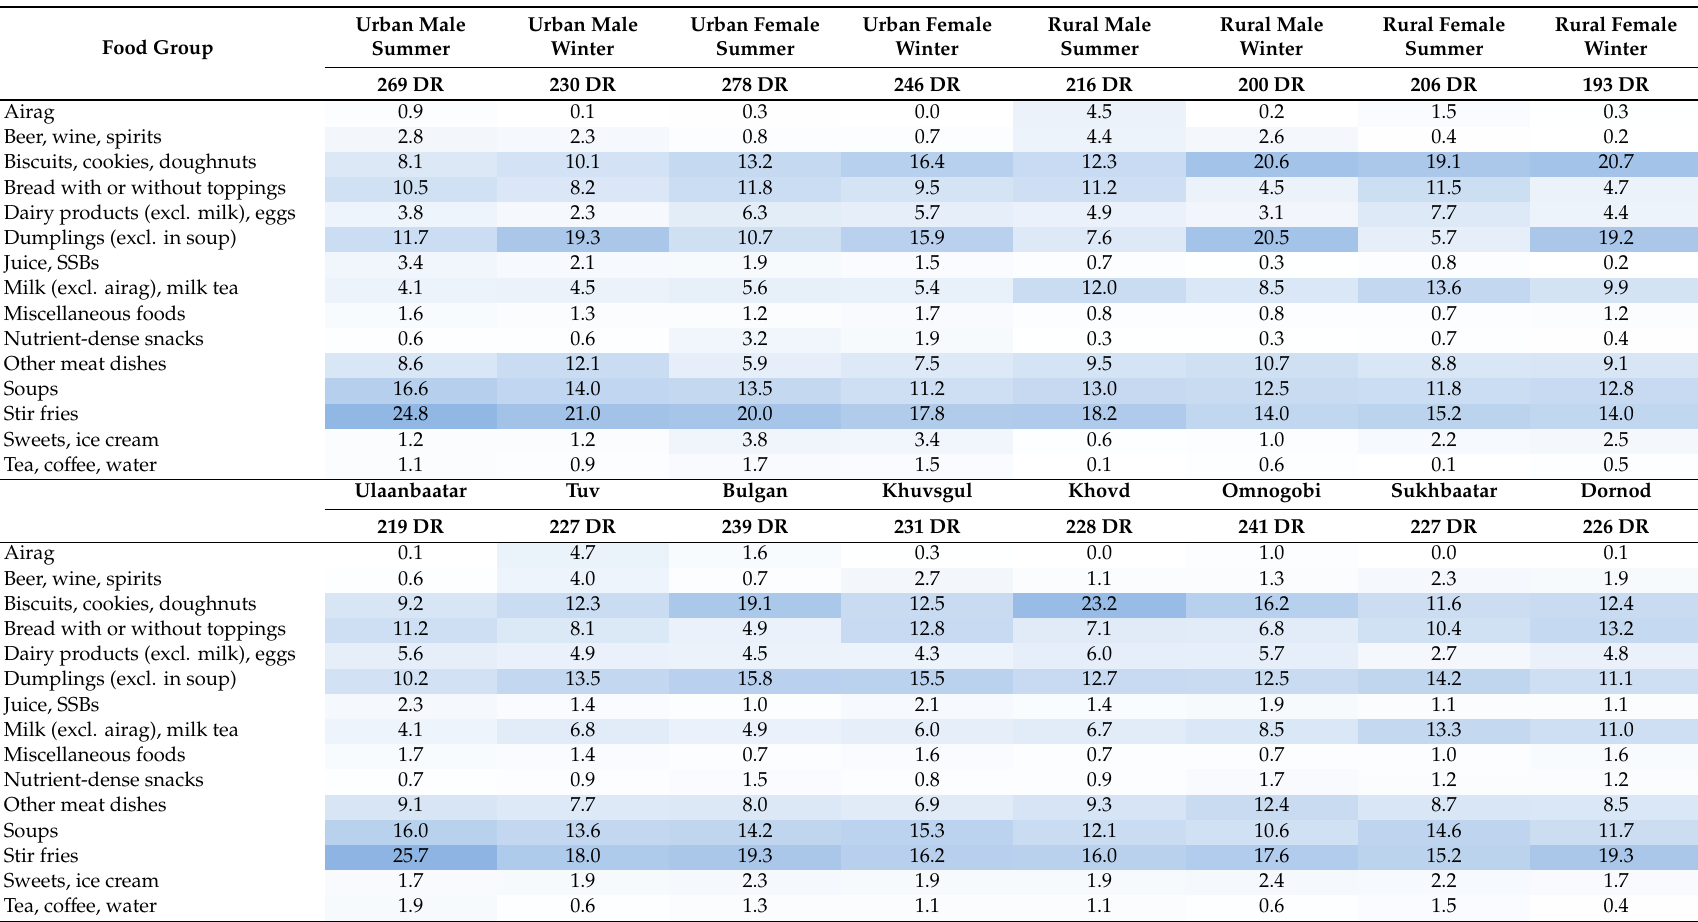
Table 3. Mean percentage of dietary energy contributed by consumed dishes by subgroup-season and